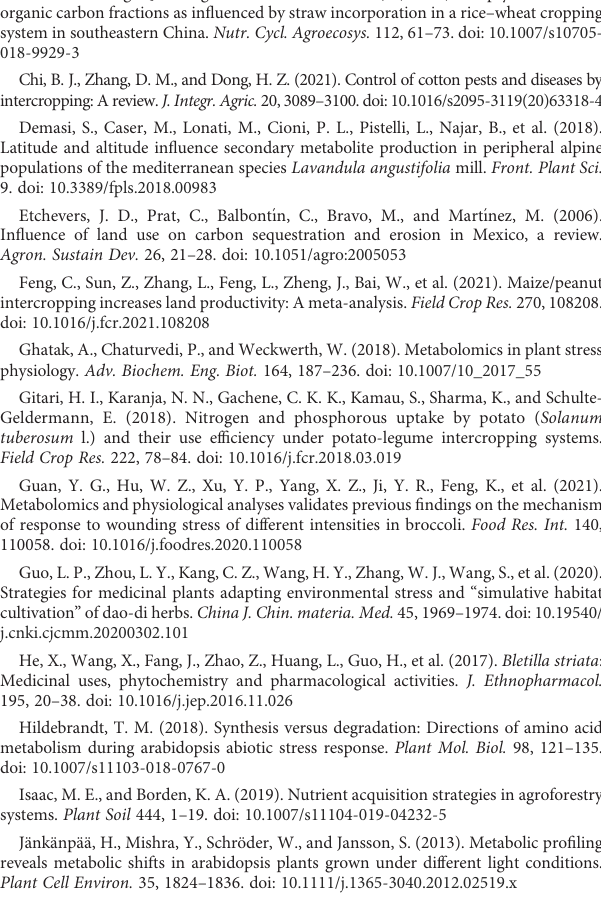
SUPPLEMENTARY FIGURE 1 The PLS-DA score plots and the permutation tests derived from GC-MS data. PLS-DA score plots (A) and (C) and the permutation tests (B) and (D) derived from GC-MS data of the Bletilla pseudobulb. The (A) and (B) indicates the Cyclocarya paliurus intercropping with B. striata (CB) vs . Control; (C) and (D) indicate the Moso bamboo intercropping with B. striata (PB) vs .